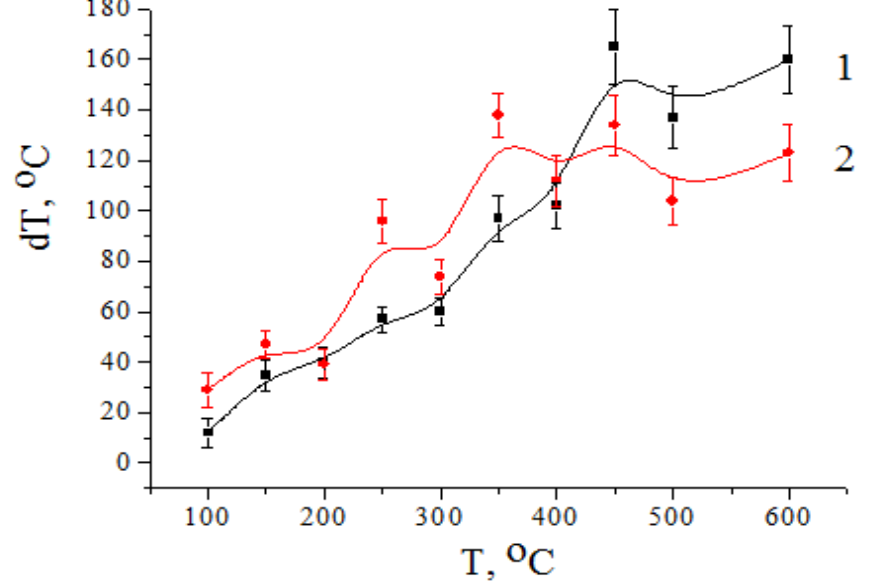
Figure 6. The average temperature dependence on the film’s temperature gradient—without ZnO filler (1) and with ZnO filler (2).